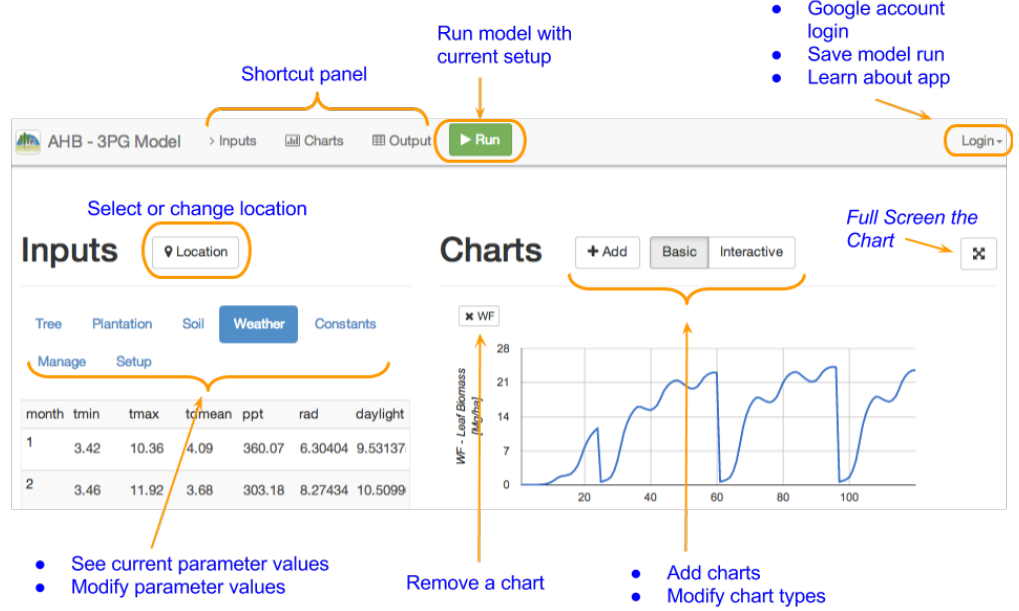
Figure 2. User interface